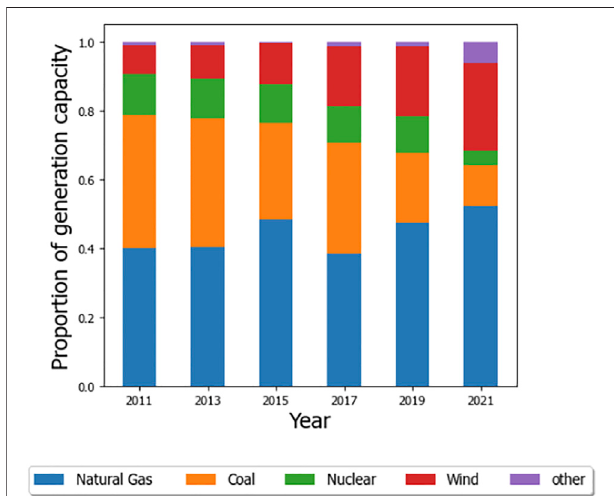
FIGURE 5 | Structure of installed generation capacity in ERCOT from 2011 to